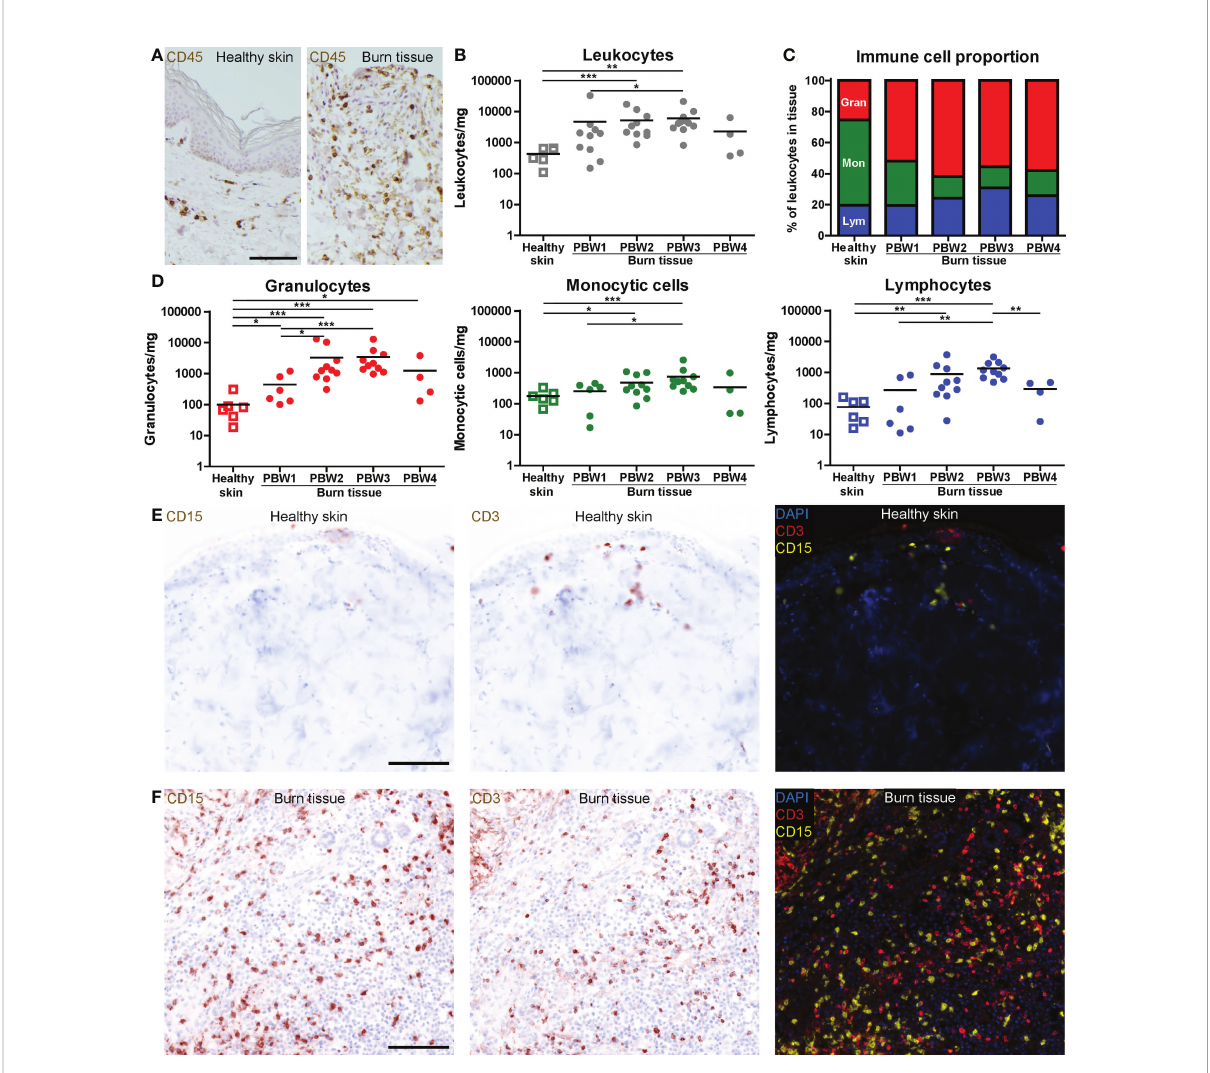
FIGURE 1 High number of immune cells in fi ltrate the skin as response to burn injury. (A) CD45 immunohistochemical DAB staining of a representative section of healthy skin and burn tissue (from 15 days post burn) (black scale bar = 100 µm). Flow cytometry-based quanti fi cation of: (B) Absolute number of leukocytes per mg tissue (based on side scatter and CD45); (C) Proportion of granulocytes (Gran), monocytic cells (Mon) and lymphocytes (Lym) in tissue (based on side scatter and CD45); (D) Absolute numbers of granulocytes, monocytic cells and lymphocytes per mg tissue (based on side scatter and CD45). Microscopic image of multiplex DAPI, CD15 (granulocytes) and CD3 (T cells) staining of a representative: (E) Healthy skin sample; (F) Burn tissue sample (from 25 days post burn), shown separately and as composite (black scale bar = 100 µm). P values were calculated using Mann-Whitney U statistical tests, signi fi cant differences are indicated by black asterisks: *p < 0.05; **p < 0.01; ***p <